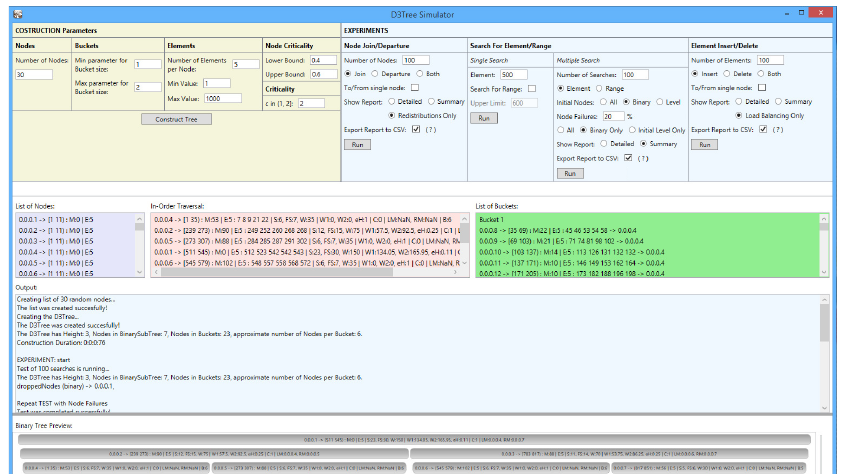
Figure 5. The D 3 -Tree simulator user